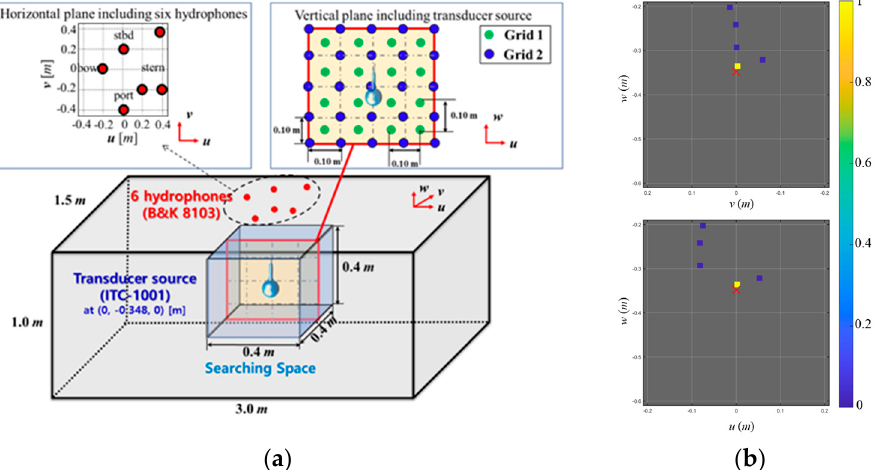
Figure 9. ( a ) Configuration of the transducer experiment, and ( b ) localization result using the pairwise off-grid BSBL. The five largest components were projected onto the 𝑢 – 𝑤 (looking from the port side) and 𝑣 – 𝑤 (looking from the stern side) planes. A single dominant component represented the transducer position at (0.002, − 0.335, − 0.003) m.